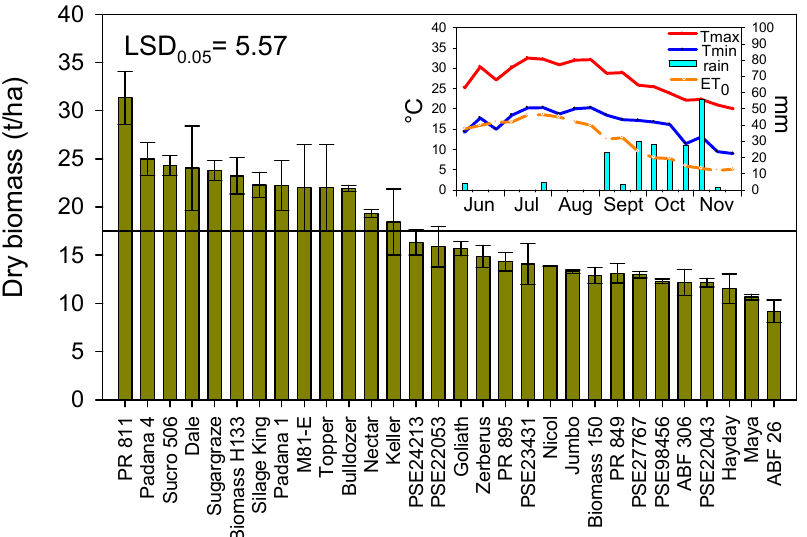
Figure 4. Dry biomass in thirty cultivars of sorghum measured in 2010 field experiment. Inset figure reports the meteorological trend (Tmax and Tmin as average values of 10-day period, rain and ET0 as cumulative values of 10-day period) recorded during the experiment (Catania, IT, 10 m a.s.l., 37°25 ′ N Lat, 15°30 ′ E Long).